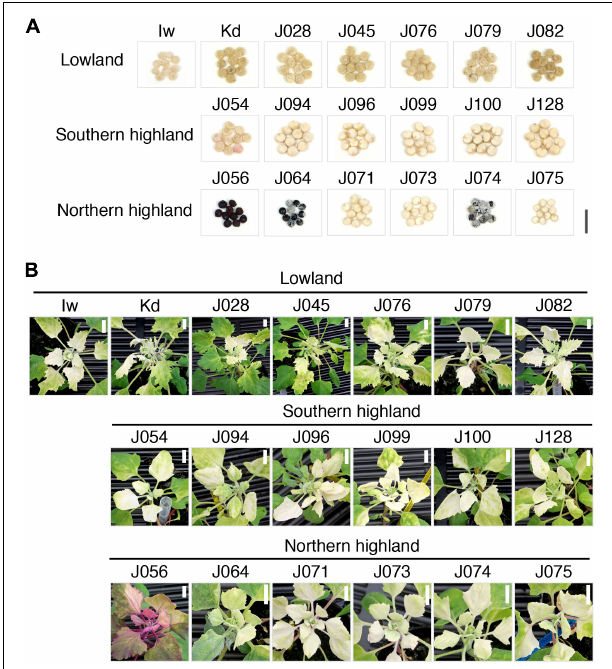
FIGURE 2 | The ALSV vector is suitable for gene function analysis in a variety of quinoa inbred lines. (A) Representative images of quinoa seeds of 19 representative inbred lines, including seven lowland, six southern, and six northern highland lines. Each representative inbred line selected in this analysis contains 100% of the genetic background of each sub-population based on the results of our previous GBS analysis of the inbred quinoa lines (Mizuno et al., 2020). Scale bar represents 5 mm. (B) Representative images of the 19 representative inbred line plants at 16 dpi with ALSV-CqPDSC. Scale bars represent 1